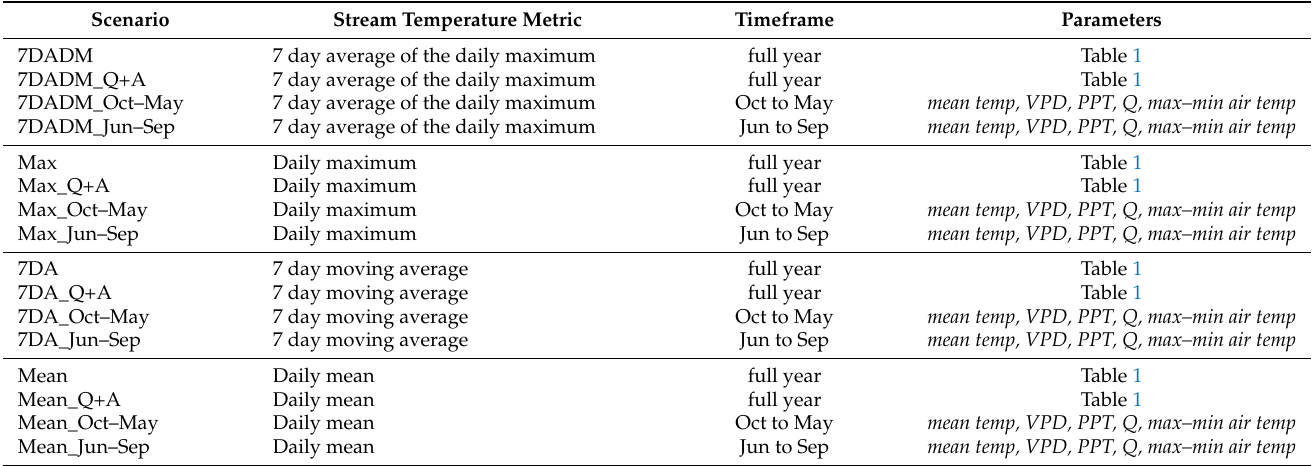
Table 2. SVR parameterization for the different scenarios tested in this study.